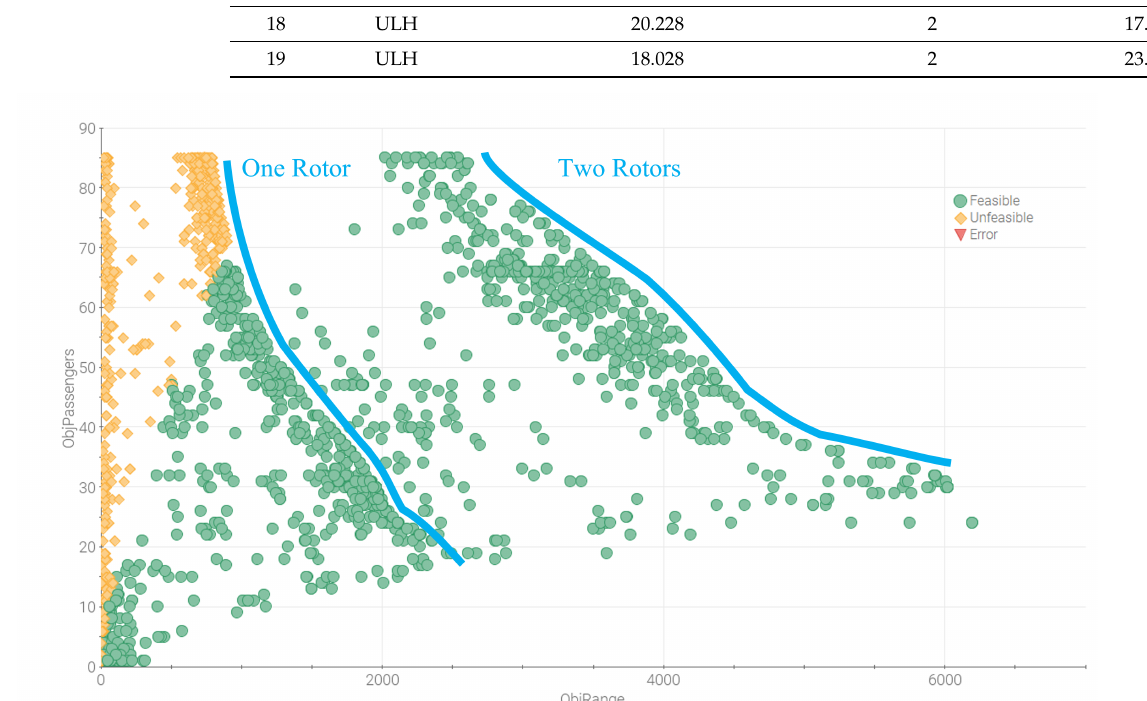
Figure 6. A scatter graph for the number of passengers against the helicopter range. Two Pareto fronts for the number of rotors are identified and marked in